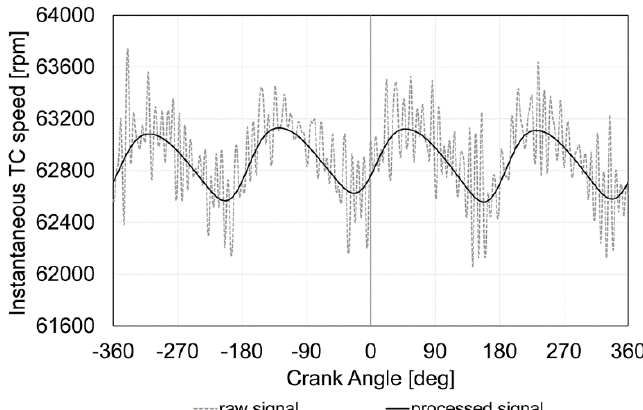
Figure 8. The original instantaneous TC speed signal related to one engine cycle (light grey) and the post-processed one (black). Instantaneous TC speed signal by the moving average method (88 blades). The post-processed signal is referred to the average of multiple engine cycles with the application of the pass-band filter. Data correspond to 1000 rpm at full load.